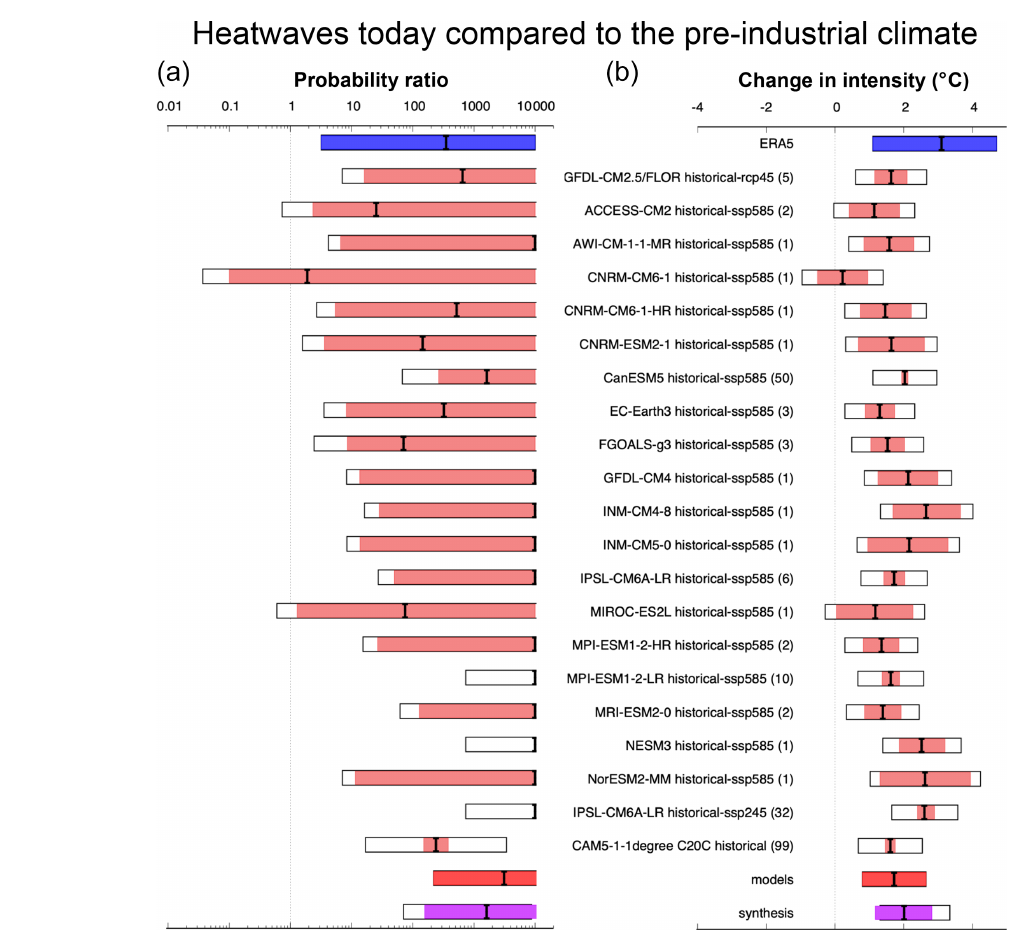
Figure 12. Synthesis of the past climate, showing probability ratios (a) and changes in intensity in degrees Celsius (b) , comparing the 2021 event with a pre-industrial climate. The blue bars show ERA5 results, the light-red bars the model results, with model uncertainty shown as white bars around them. The model average is shown by the bright-red bars. The magenta bars are the synthesised values, and the white box accompanying the magenta bar indicates the more conservative estimate of an unweighted average of observations and models. Model names include the model experiment and scenario and the number of ensemble members in